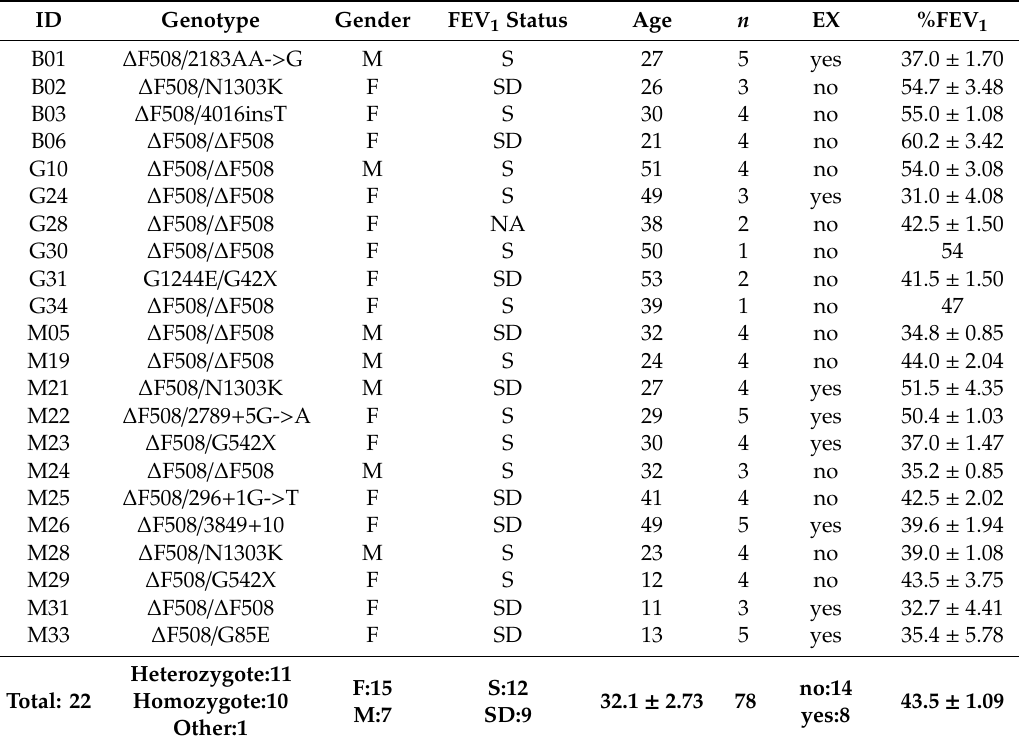
Table 1. Characteristics of patients enrolled in the